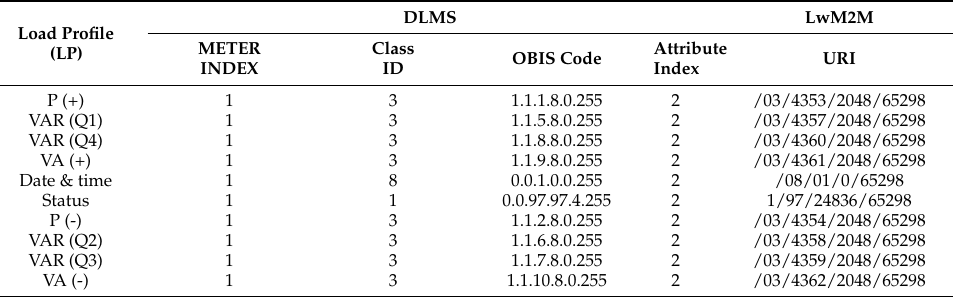
Table 5. Example of resource conversion between DLMS and LwM2M protocols. Load Profile